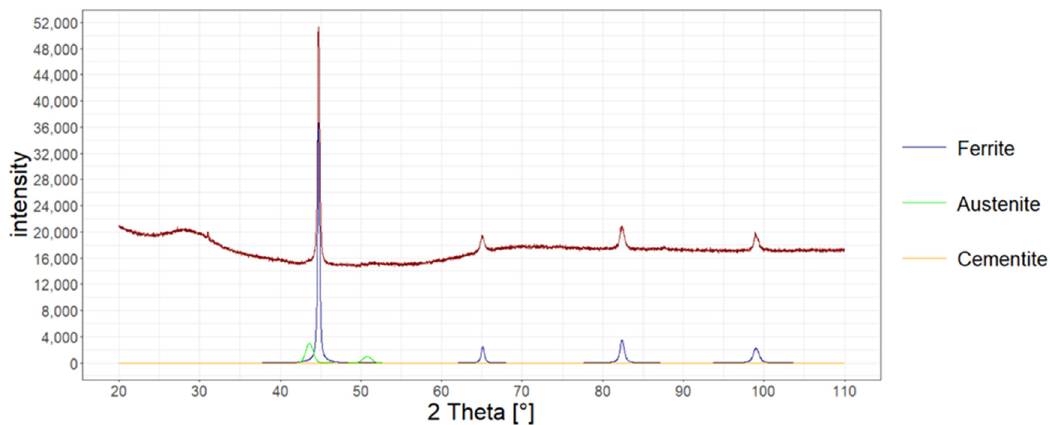
Figure 8. Phase graph of the X ‐ ray diffraction of the tested heat ‐ treated steel according to variant No. 1.